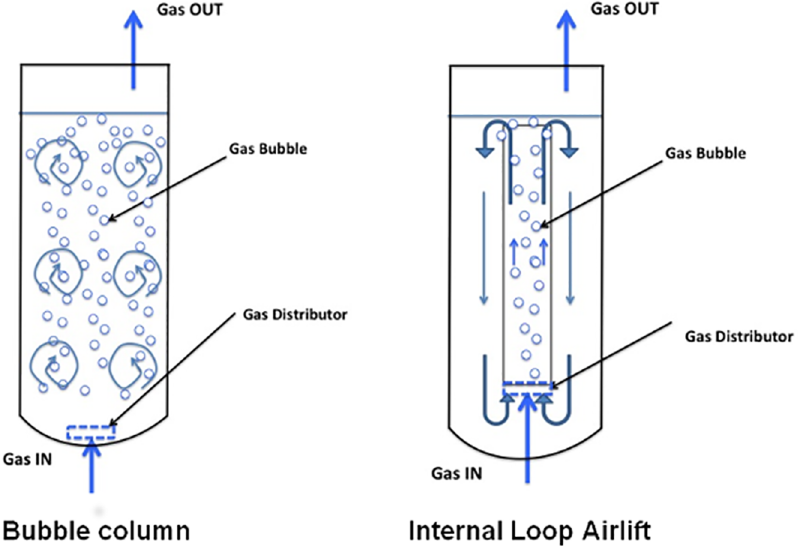
Fig 1. Sketch of the gas-liquid-solids bioreactor investigated. Liquidflow patterns are